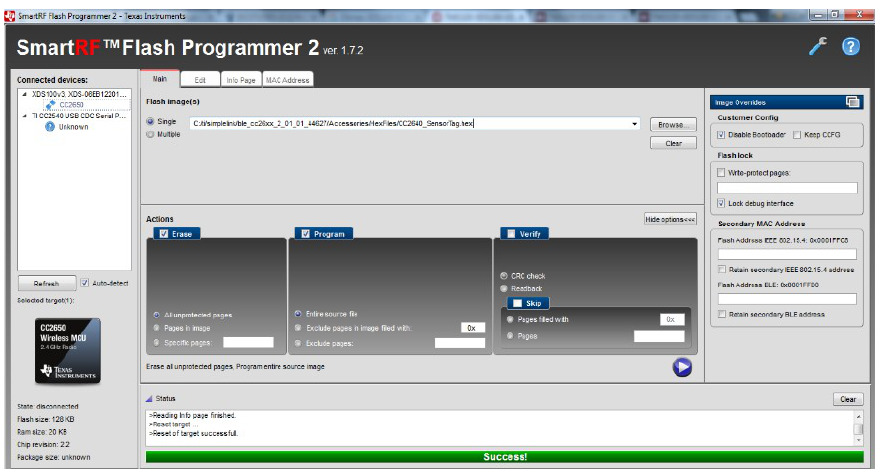
Figure A4. Patching the SensorTag through SmartRF Flash Programmer v2.